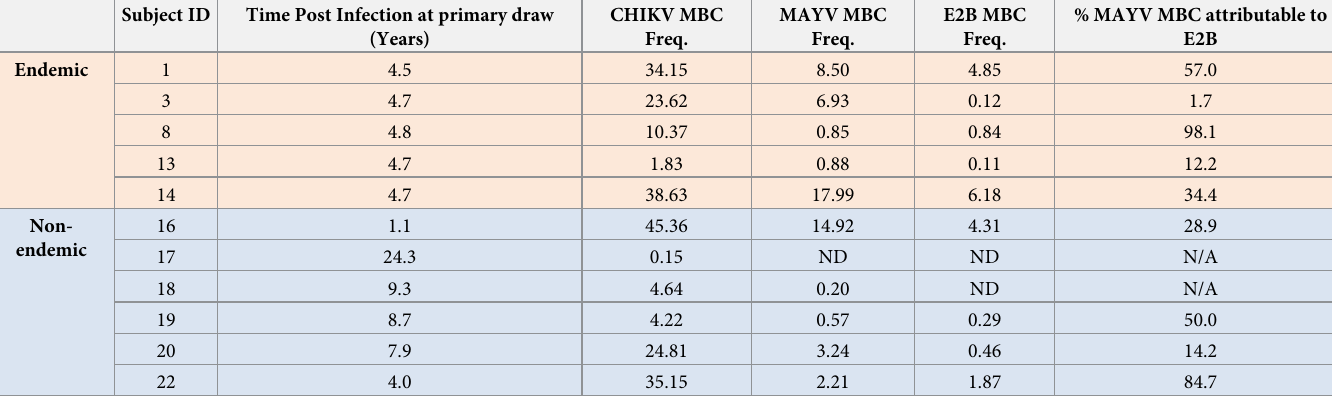
Table 2. Antigen-specific MBC frequency for non-endemic and endemic cohorts. Table summarizes subject sampling time post-infection, MBC frequencies for the three antigens tested, and % MAYV MBC attributable to E2B, determined by E2B MBC frequency divided by total MAYV-MBC frequency. ND = not detected, N/A = not